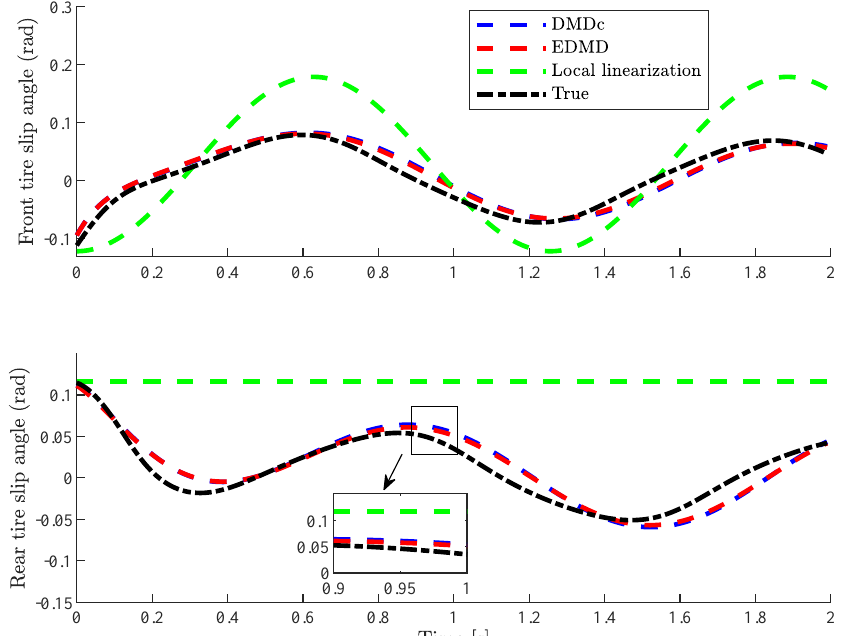
Figure 10. The front and rear tire slip angles (Scenario